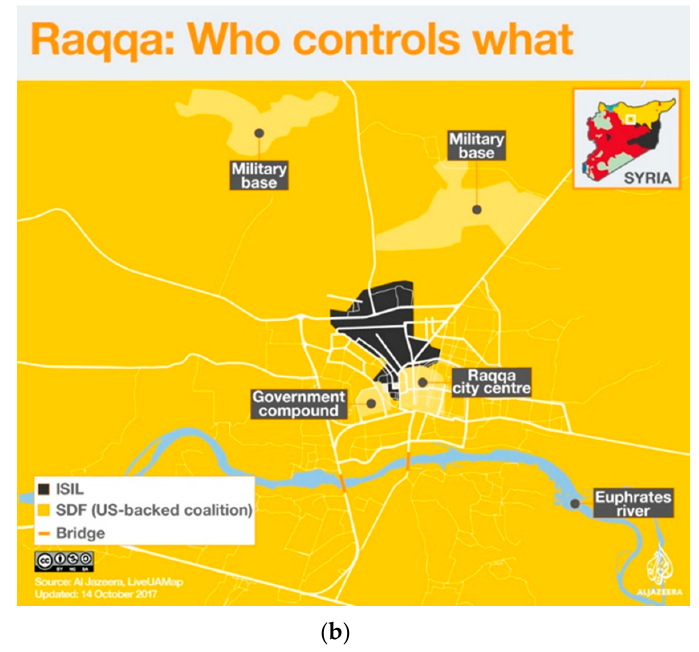
Figure 18. Comparison of Raqqa standard deviation map ( a ) and territory map ( b ) produced by Aljazeera [43].